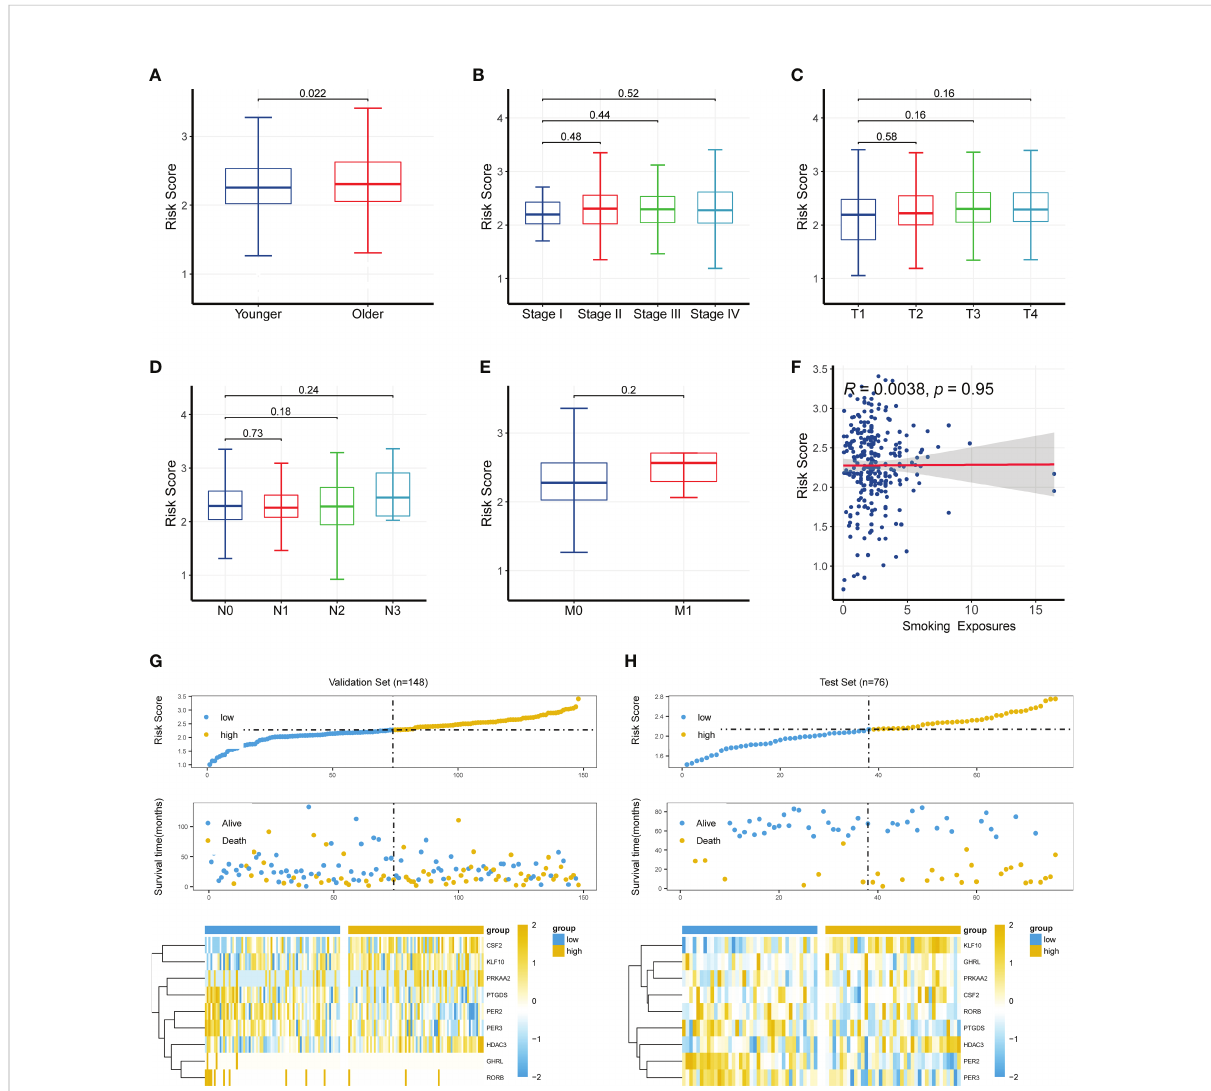
FIGURE 4 Clinical signi fi cance of the circadian rhythm-related gene signature. (A) Older patients had a higher risk score than younger patients (cutoff value of 60 years old; P < 0.05). (B – F) The risk score was not related to clinical stage, TNM staging, or smoking exposure. (G) A higher risk score was associated with a higher mortality and a higher expression level of CSF2, KLF10, PRKAA2, and HDAC3 in the training set. (H) A higher risk score was associated with a higher mortality and a higher expression level of CSF2, KLF10, PRKAA2, and HDAC3 in the validation